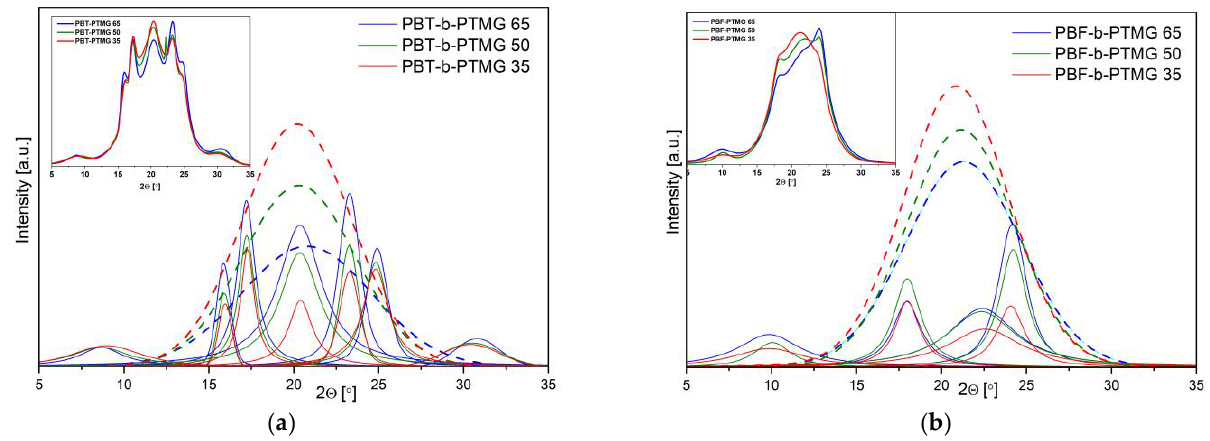
Figure 5. WAXS patterns of injection molded samples after deconvolution to crystalline peaks and amorphous halo for ( a ) PBT-b-PTMG and ( b ) PBF-b-PTMG copolymers (the original data presented in boxes). The spectra received after two days from processing. The amorphous halo peaks are in dash line.